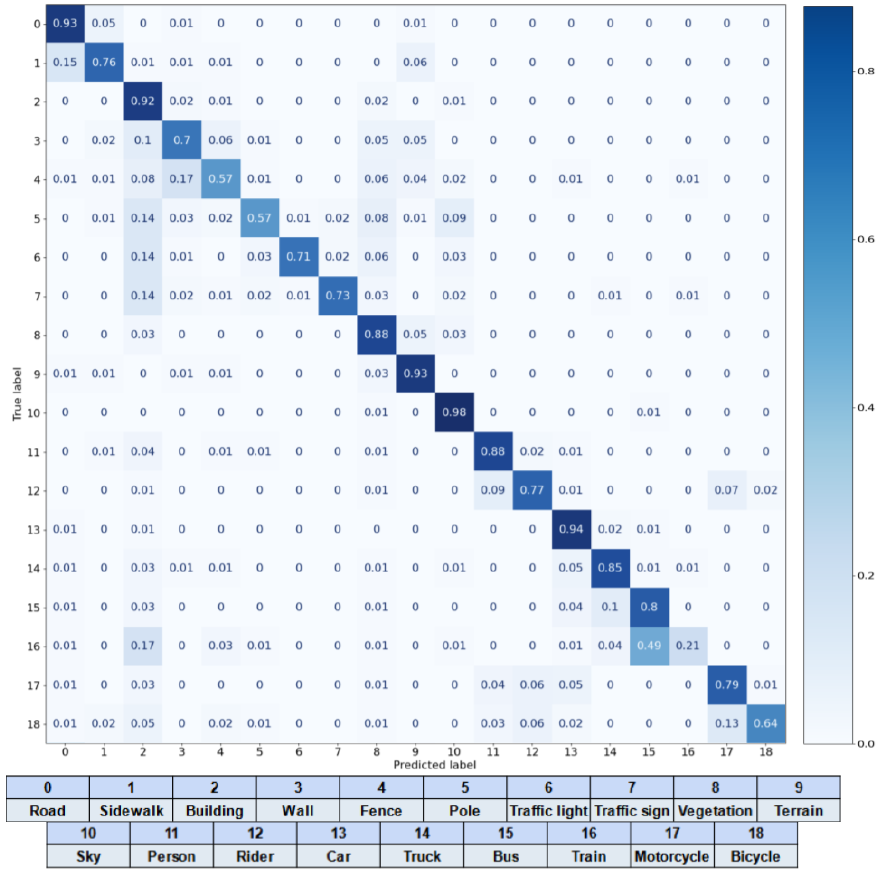
Figure A3. Confusion matrix of the co-training model trained with GTAV + Synscapes as source data and Mapillary Vistas as target